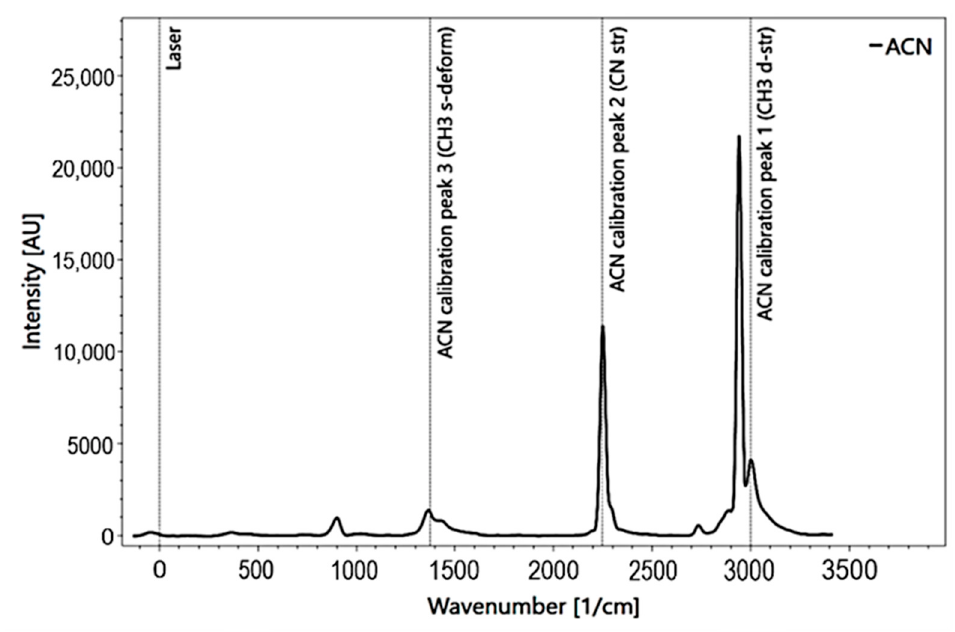
Figure 3. Acetonitrile calibration spectrum for Raman spectroscopy with added peak information. To perform a Raman measurement, a grid with 3600 grid lines per millimeter was selected. For the analysis, the dark spectrum was subtracted from the raw spectrum (Figure 4).